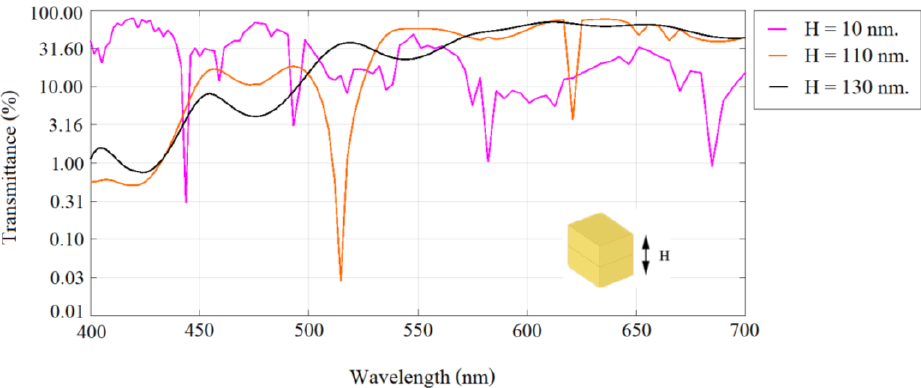
Figure 4. Transmittance when H is varied from 10 to 130 nm.